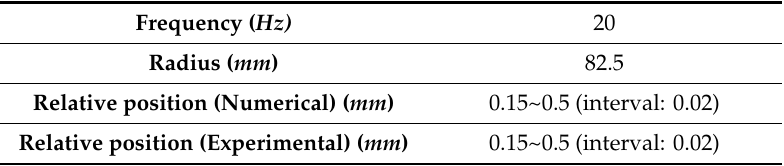
Table 7. Experimental setup